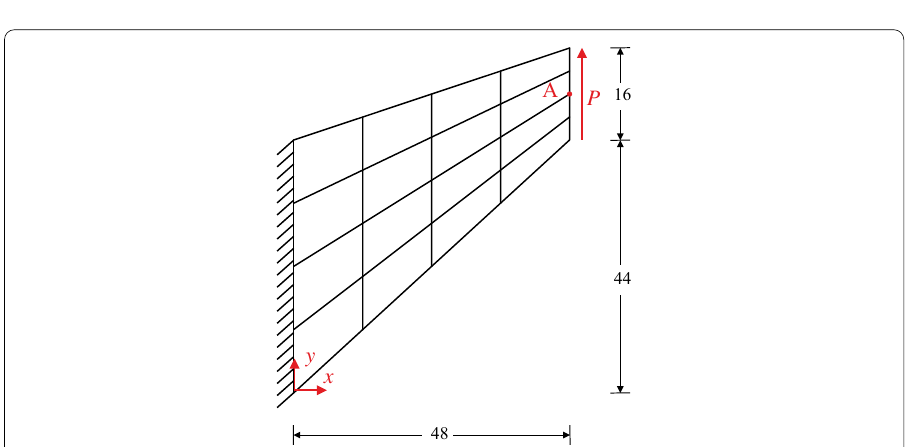
Fig. 28 Hook problem: deformed mesh for P = 1